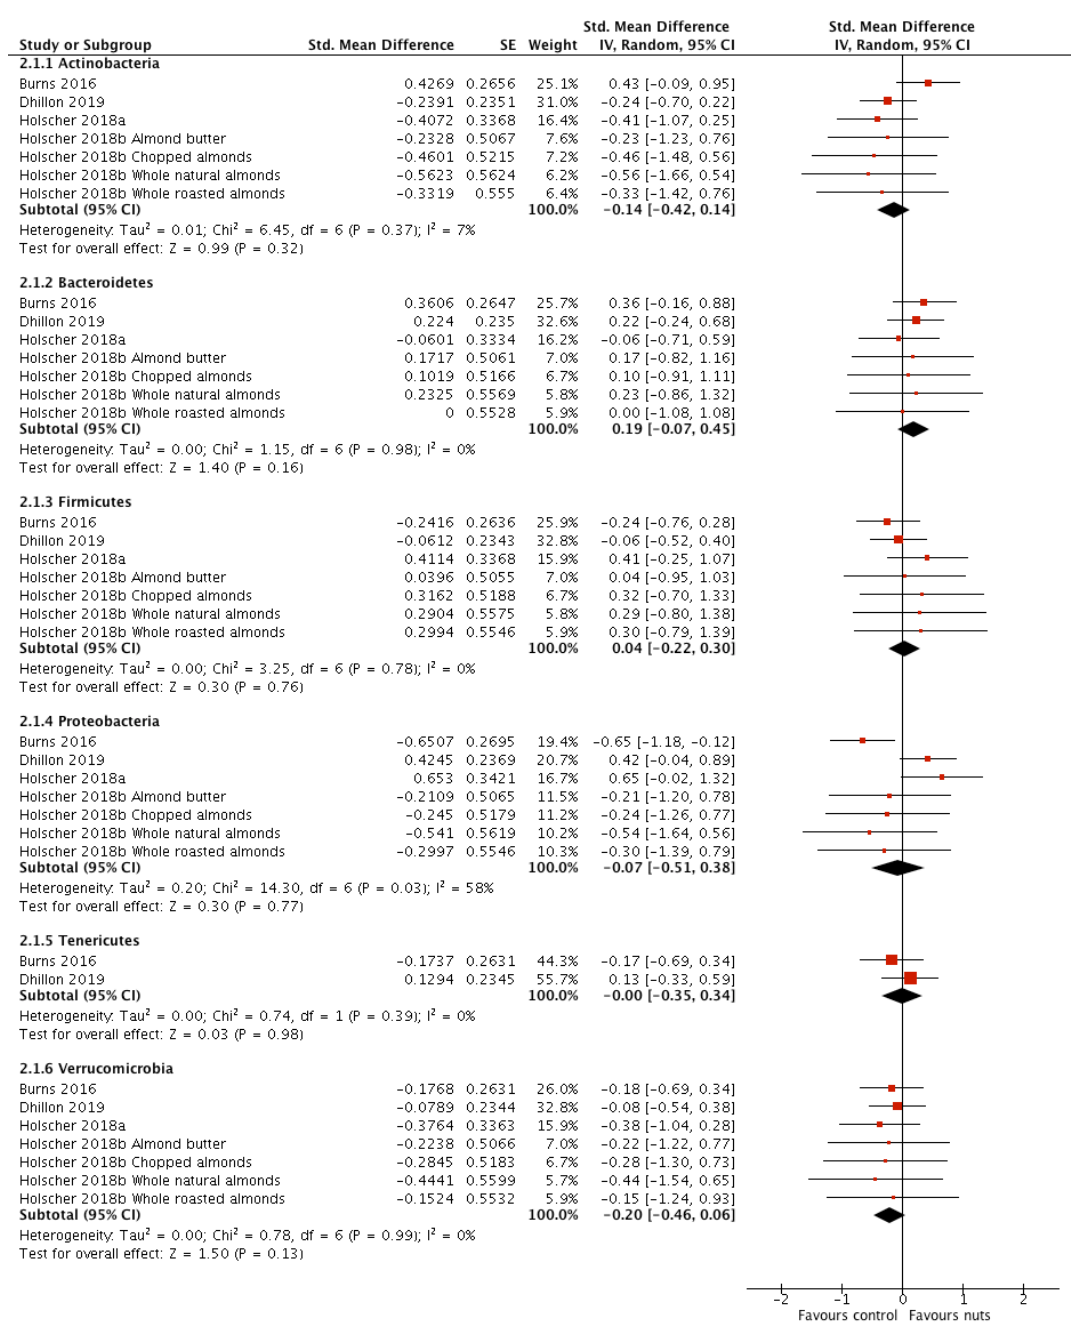
Figure 2. Forest plot of relative abundance of bacterial phyla measured in faecal samples of participants taking part in randomised controlled trials comparing nut consumption to control in adults. Meta-analyses were conducted using a random effects model. Values are standardised mean difference (95% confidence interval).